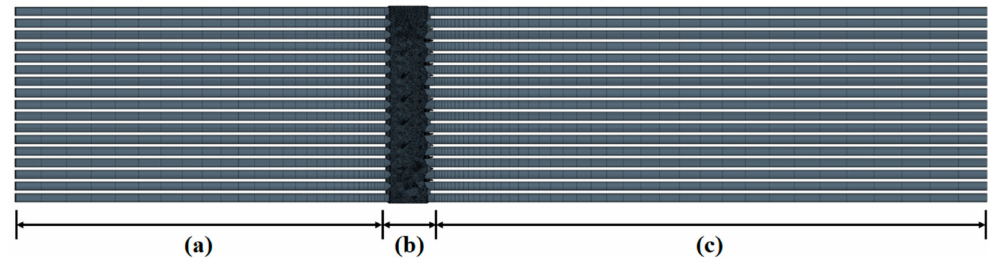
Figure 3. Di ff erent kinds of mesh: ( a ) extruded mesh; ( b ) polyhedral mesh; ( c ) extruded mesh.